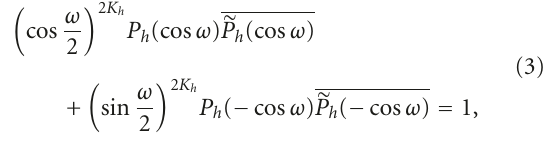
Figure 2: Filter bank structure of dual biorthogonal